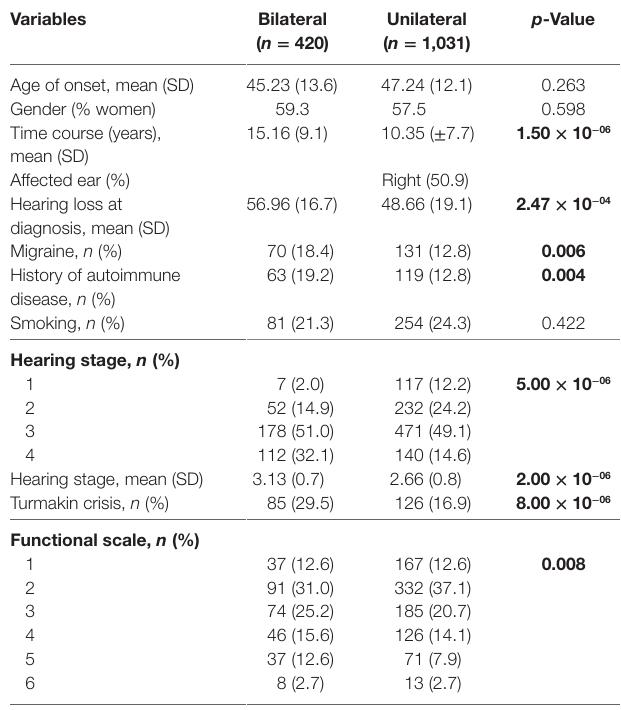
TaBle 2 | Clinical features of patients with sporadic Meniere’s